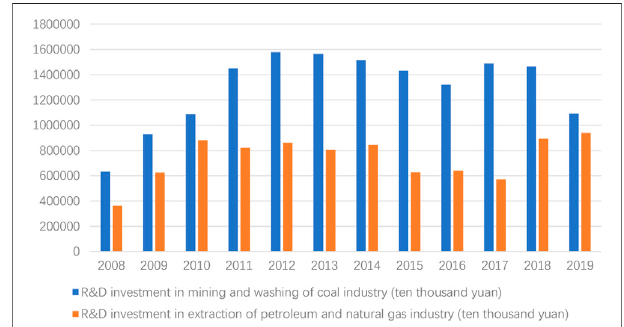
FIGURE4 | R&D investment in mining and washing ofcoal, extraction of petroleum and natural gas industries (2008 – 2019). Data Sources: China Statistical Yearbook 2009 – 2020.